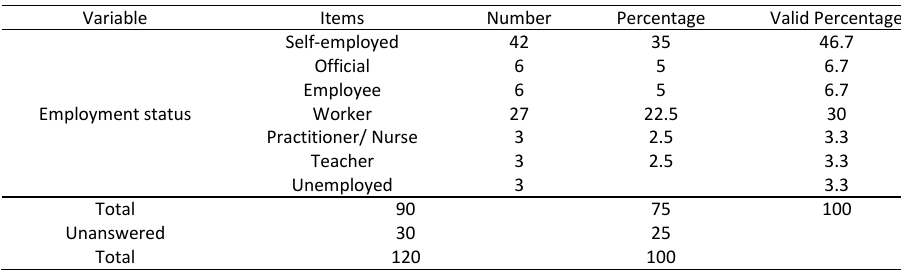
Table 2: Frequency distribution of Respondents’ employment